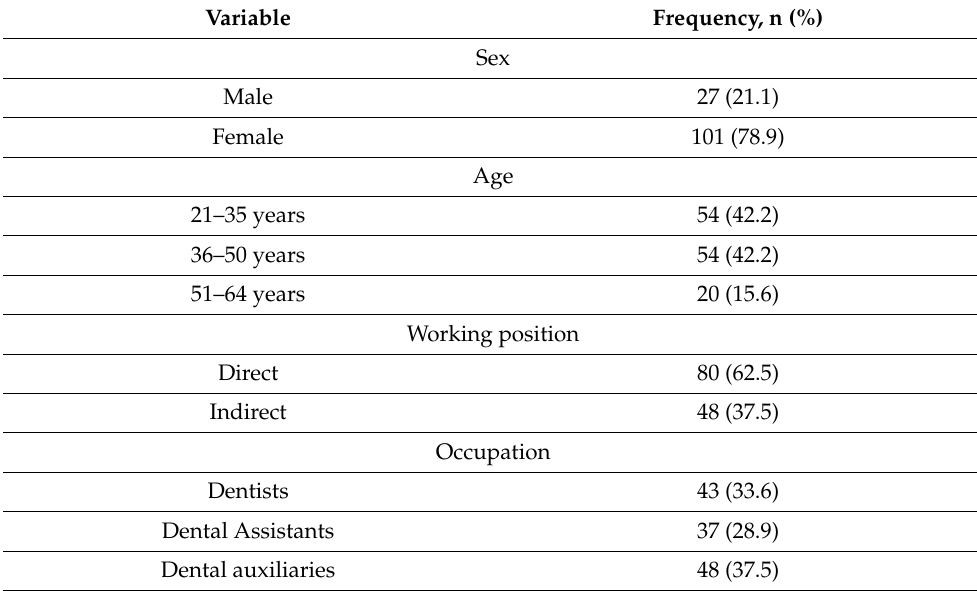
Table 1. Participant demographic characteristics.